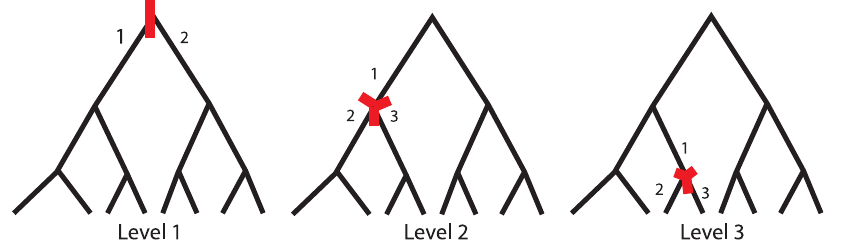
Figure 1. Illustration of generation of factor levels by bi- or trisection of the genealogies. The red mark illustrates the node where the genealogy is cut. Cutting at level 1 generates two haplotype clusters (1, 2), cutting at levels 2 and 3 generates three haplotype clusters (1, 2, 3). Cutting at levels 1, 2 or 3 generates 1, 2 and 4 clustering each, respectively.